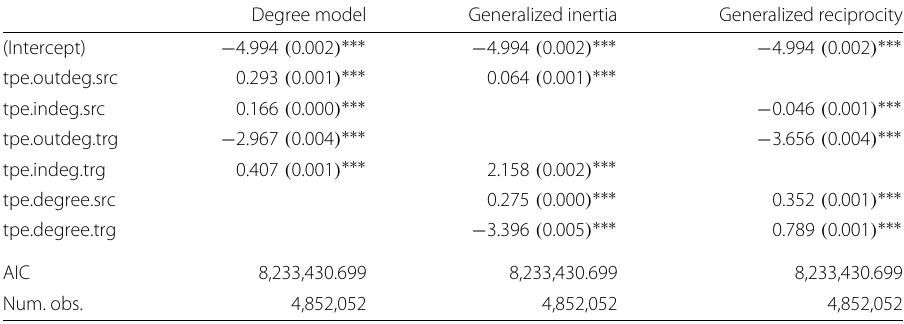
Table 8 Explaining third-party edit events by past third-party edits incident to source and target (degree effects) Degree model Generalized inertia Generalized reciprocity (Intercept) − 4.994 ( 0.002 ) ∗∗∗ − 4.994 ( 0.002 ) ∗∗∗ − 4.994 ( 0.002 ) ∗∗∗ tpe.outdeg.src 0.293 ( 0.001 ) ∗∗∗ 0.064 ( 0.001 ) ∗∗∗ tpe.indeg.src 0.166 ( 0.000 ) ∗∗∗